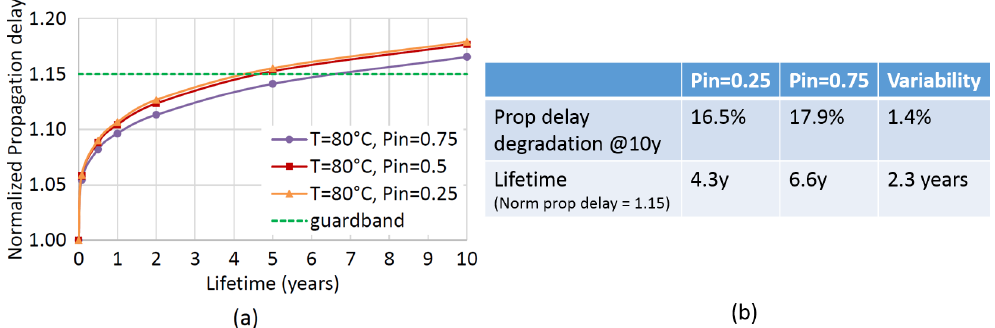
Figure 4. NOT propagation delay with BTI aging: ( a ) delay variation with different input signal probabilities; ( b ) propagation delay and lifetime